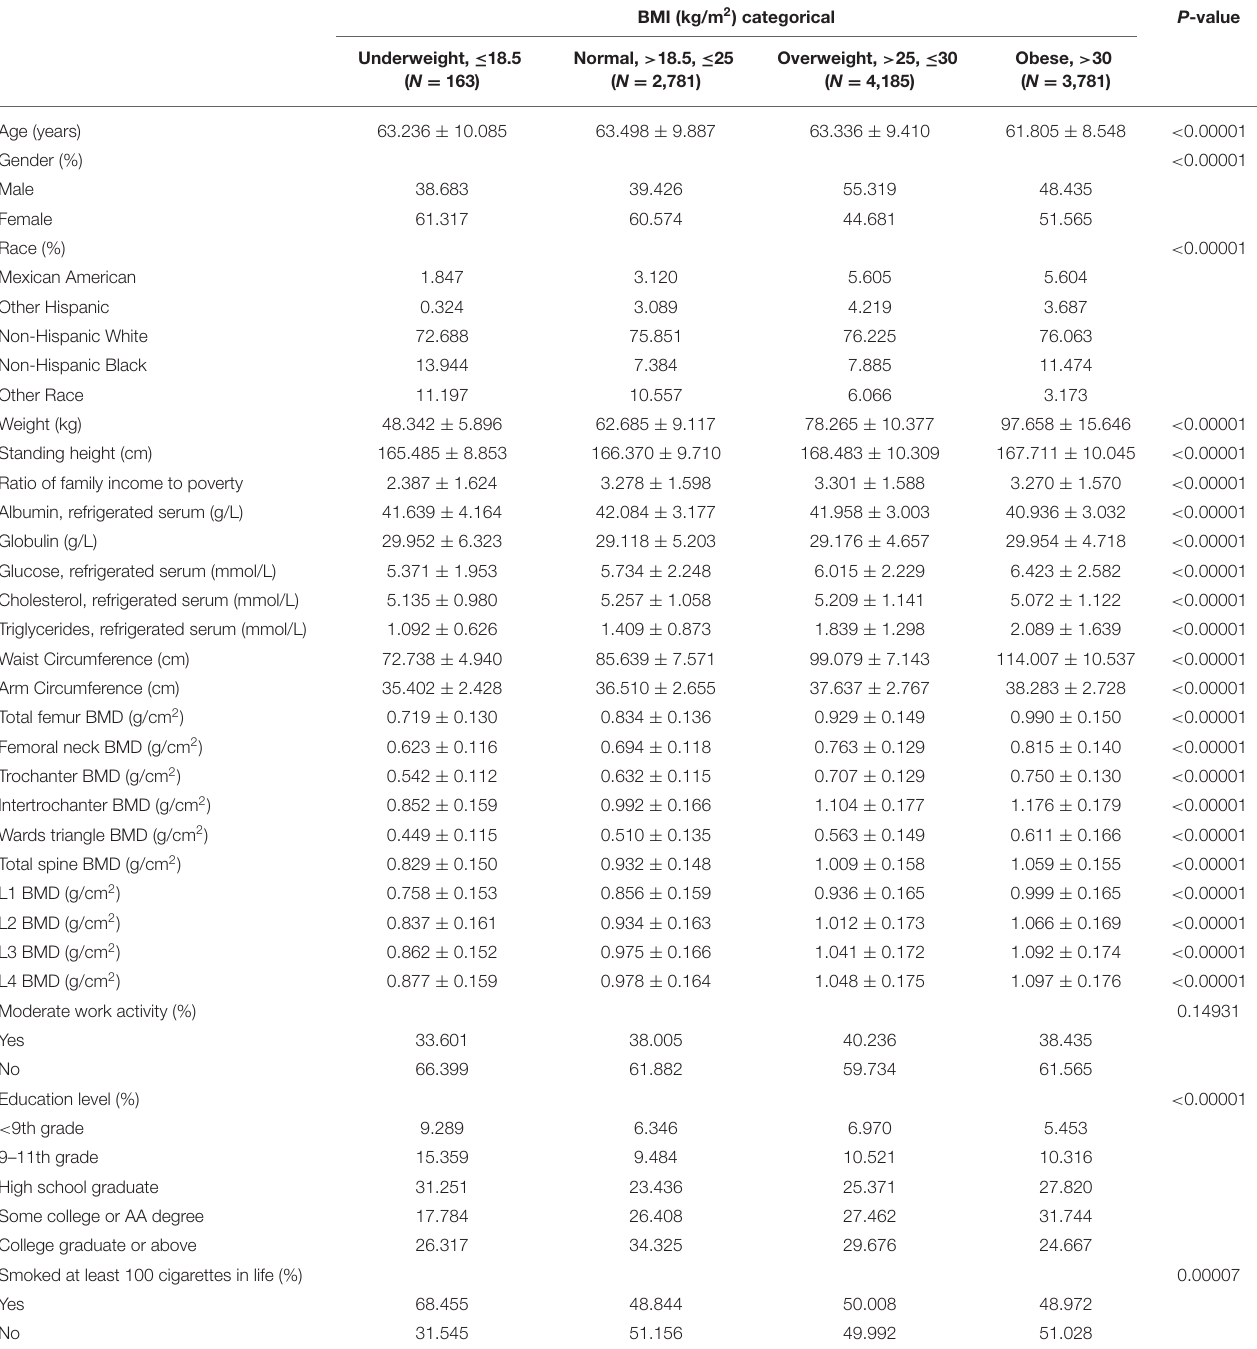
TABLE 1 | Characteristics of the study